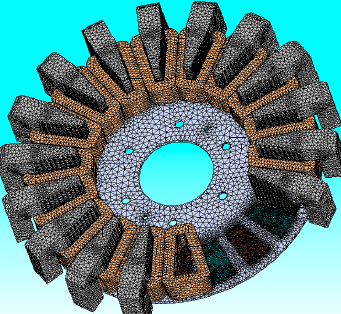
Figure 13: Stator-tooth structure before/after